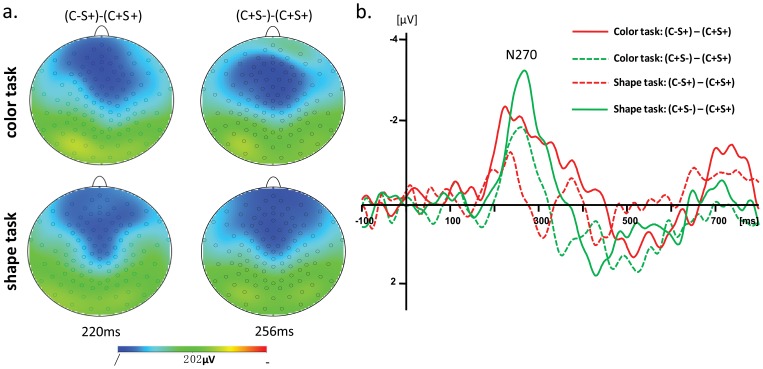
The scalp topography and difference waveforms for mismatch detection.a. The scalp topography for the difference waveforms between C−S+ and C+S+ at 236 ms and for the difference wave between C+S− and C+S+ at 260 ms. b. The difference waveforms between C−S+ and C+S+ and the difference waveforms between C+S− and C+S+ at the Fz site.